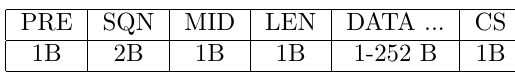
Table 1. UranusLink packet format.